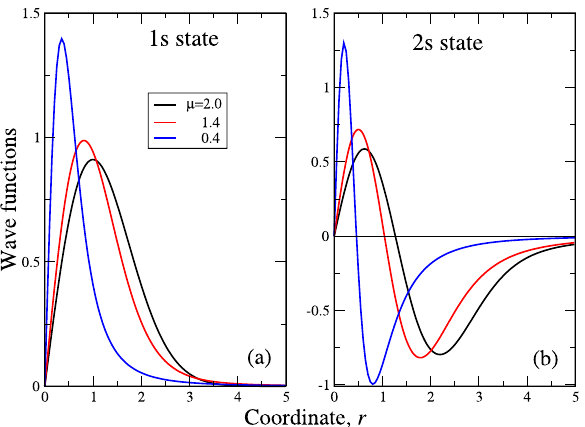
Figure 3. Wave functions of 1s ( a ) and 2s ( b ) states in the coordinate space. The values of µ are encoded by colors (legend in ( a